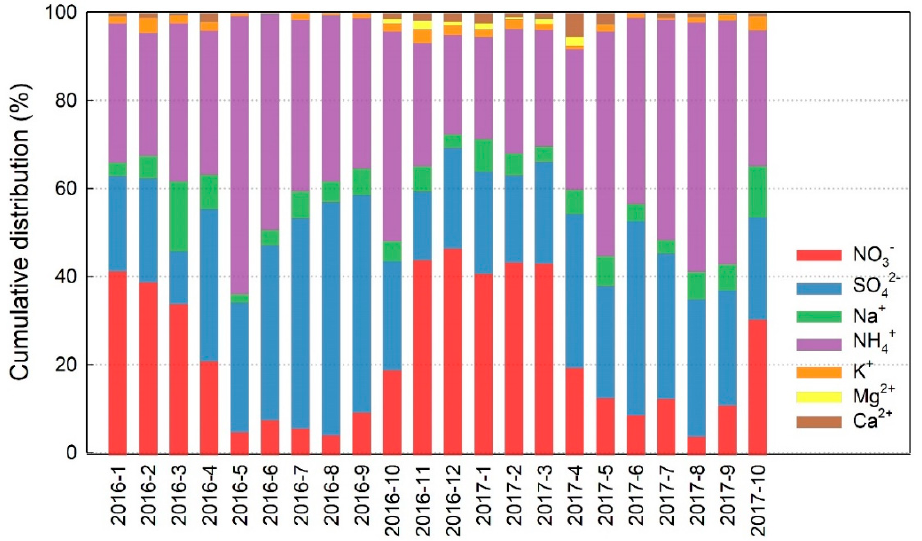
Figure 3. Monthly cumulative fractions of each ionic component with respect to the sum of all PM 2.5 ionic components.